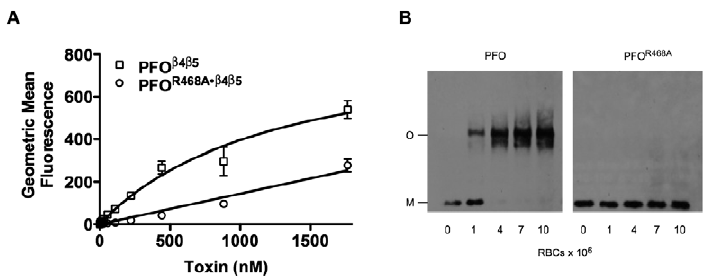
Figure 2. Binding and oligomerization of PFO and PFO R468A . (A) Binding of PFO b 4 b 5 and PFO R468A N b 4 b 5 to human RBCs (4 6 10 6 /ml in a final volume of 0.5 ml) was measured by flow cytometry. The disulfide locked b 4 b 5 versions of each protein [25] were used to prevent the lysis of the RBCs during flow cytometry. (B). Oligomerization of PFO and PFO R468A (both toxins were maintained at 440 nM)on human RBCs (concentrations ranged from 2.5 6 10 7 /ml to 2.5 6 10 8 /ml in a final volume of 40 m l) was determined using SDS-agarose gel electrophoresis (SDS-AGE) and the proteins were detected with anti-PFO antibody after transfer to nitrocellulose paper. The analyses are representative of at least 3 experiments.